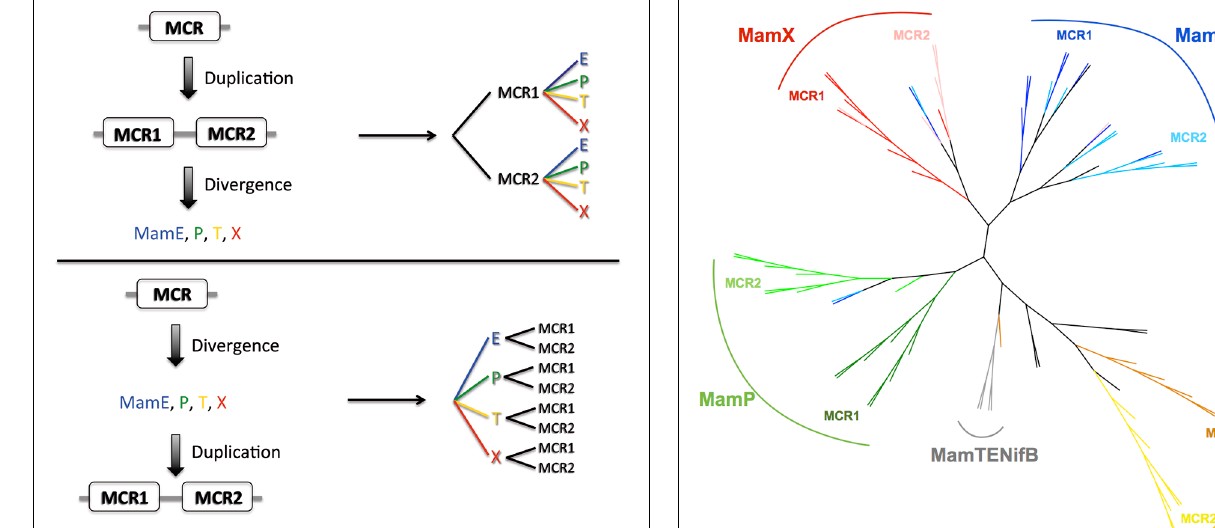
FIGURE 2 | Two models of MCR evolution. Two putative models for MCR evolution, one where the MCR domain initially duplicated and then diverged (top) and one where the MCR domain diverged before duplication. FIGURE 3 | Phylogenetic tree of MCR domains. The tree with the highest